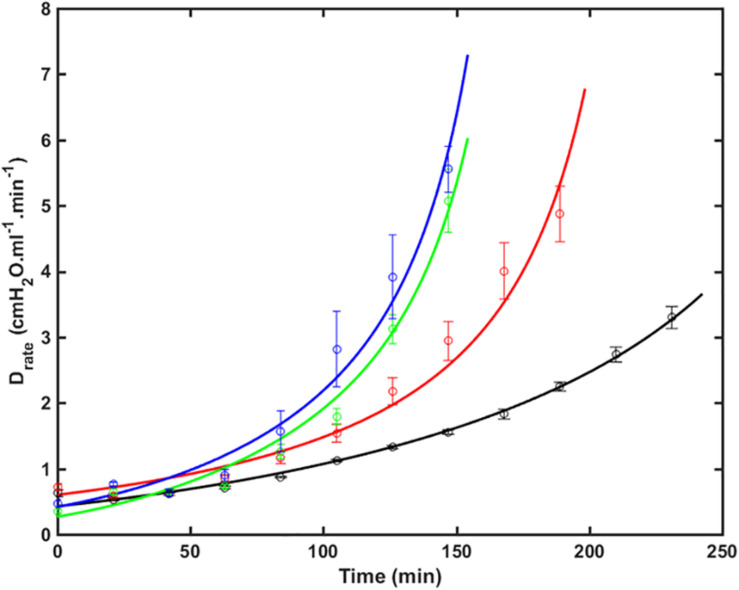
Drate (average ± SE) versus time as VILI developed in the 4 groups of mice (symbols) together with the model fits to Eq. 9 (lines). Black: V_t = 1.0 ml (RMSE = 0.35); Red: V_t = 1.1 ml (RMSE = 0.64); Green: V_t = 1.2 ml (RMSE = 0.36); Blue: V_t = 1.3 ml (RMSE = 0.65). The data were collected in a previous study (Smith et al., 2013) (RMSE – root mean squared residual.).